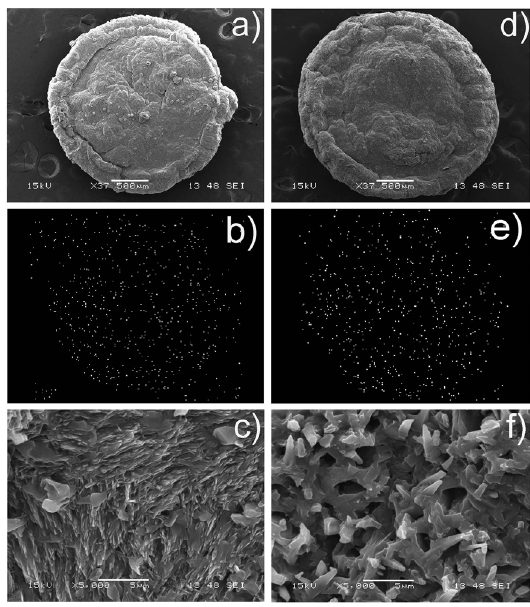
Figure 3: SEM image and EDX mapping of CTS (a-c) and CTS- 3%MMT composite beads after Ag + adsorption (d-f).